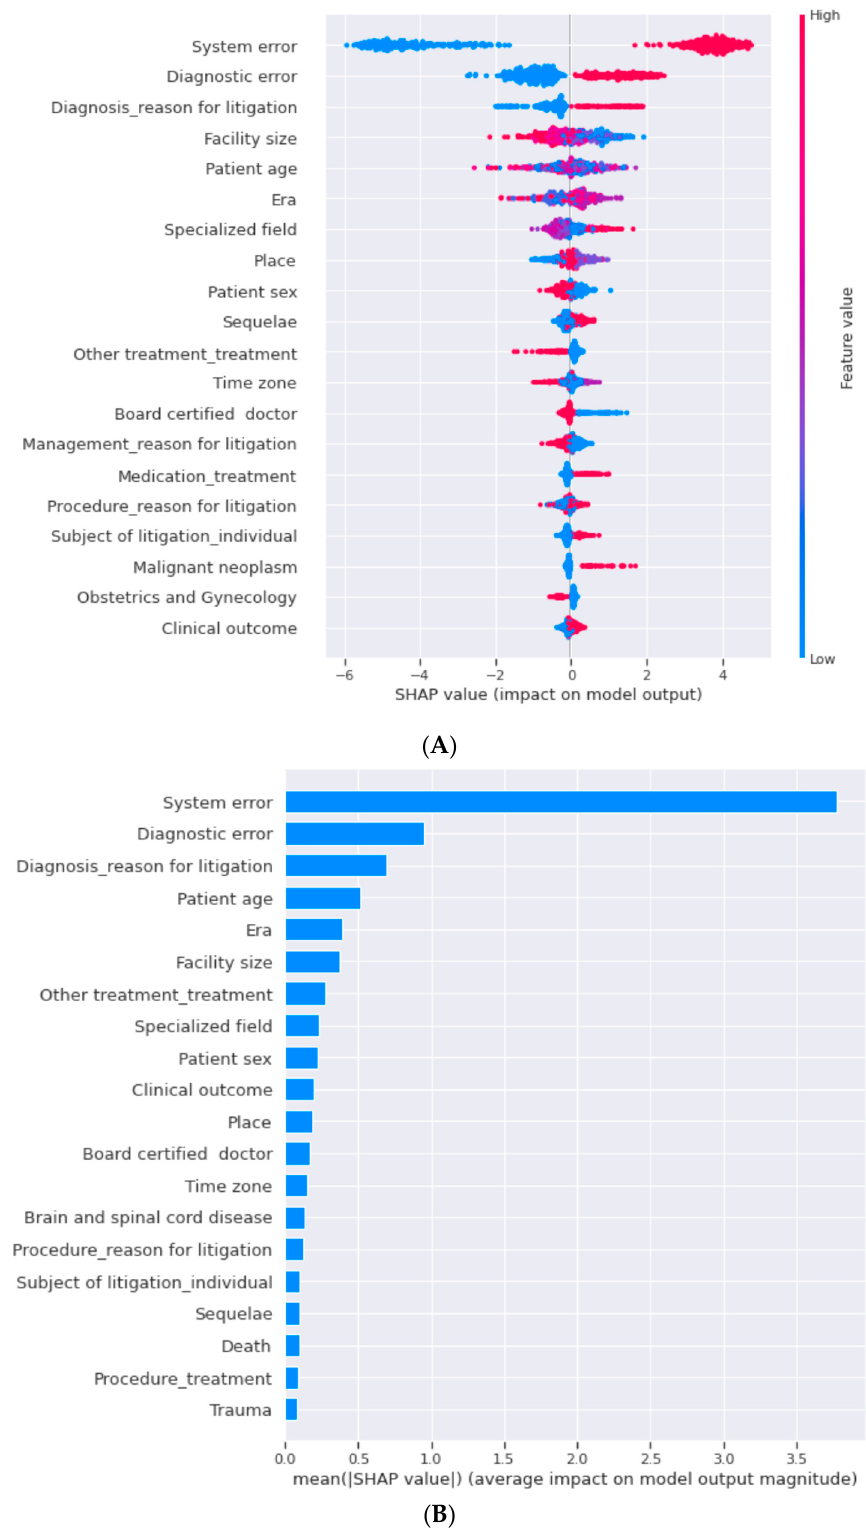
Figure 2. Feature importance in lightGBM with SHAP ( A , B ). The top five features important in lightGBM were system error, diagnostic error, the reason for litigation diagnosis, facility size, era, and patient age, in descending order.